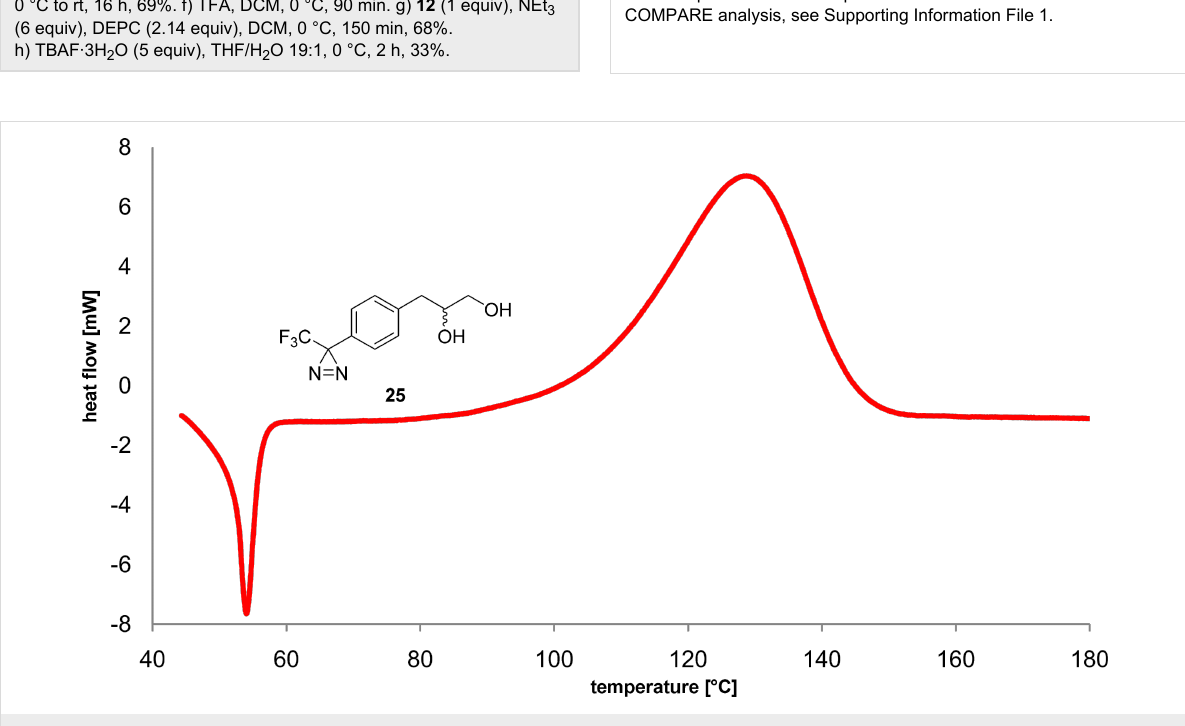
Figure 2: DSC curve of diazirine 25 , heating rate 5 °C/min.